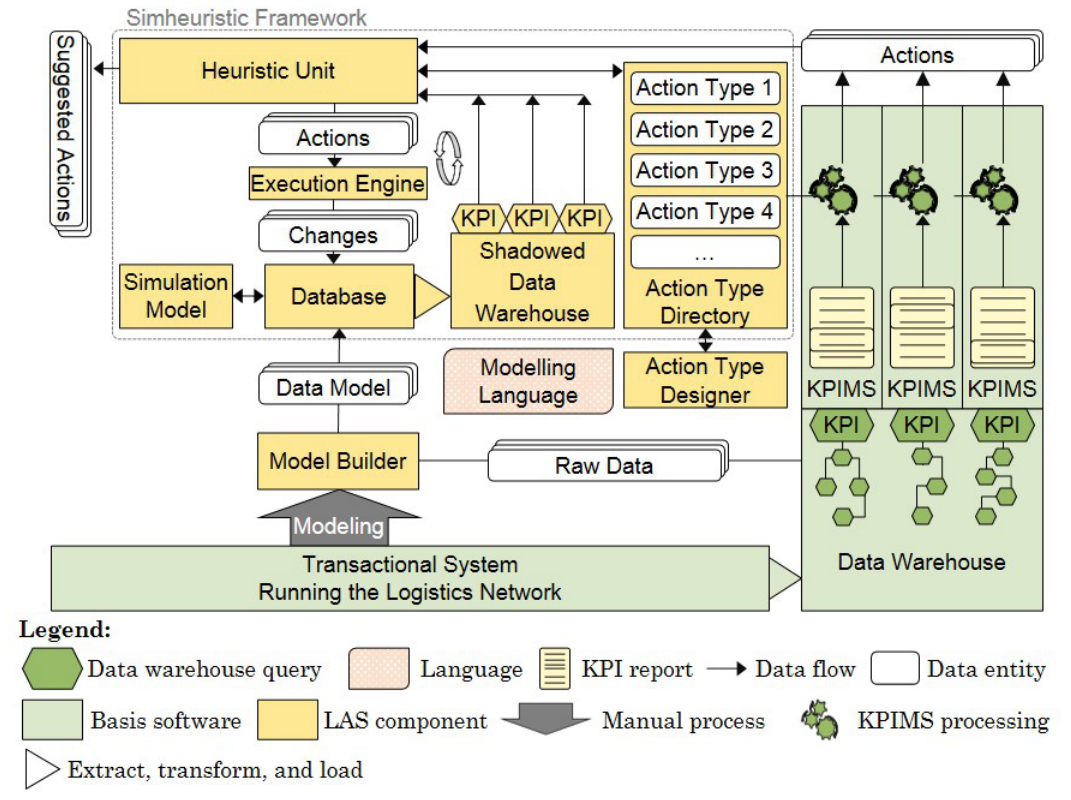
Figure 1. The architecture of the developed Logistics Assistance System (LAS)